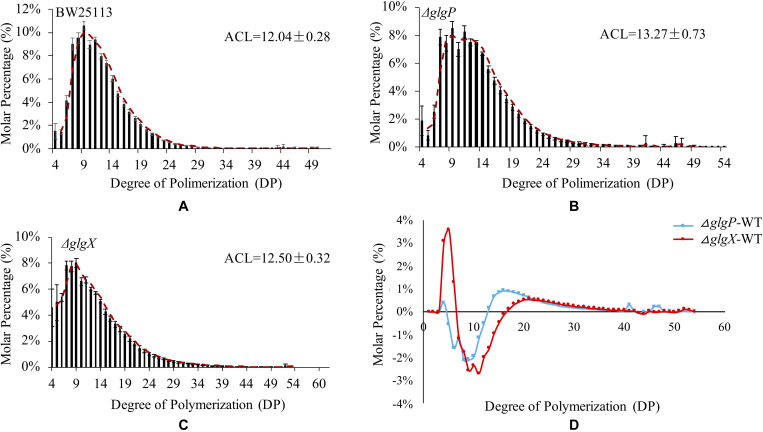
Comparison of glycogen primary structures in E. coli wild-type and mutated strains. (A) Glycogen chain length distribution patters in E. coli BW25113. (B) Glycogen chain length distribution patters in E. coli BW25113 ΔglgP. (C) Glycogen chain length distribution patters in E. coli BW25113 ΔglgX. (D) Differential distributions of chain-length molar percentages among wild-type BW25113, ΔglgP, and ΔglgX.